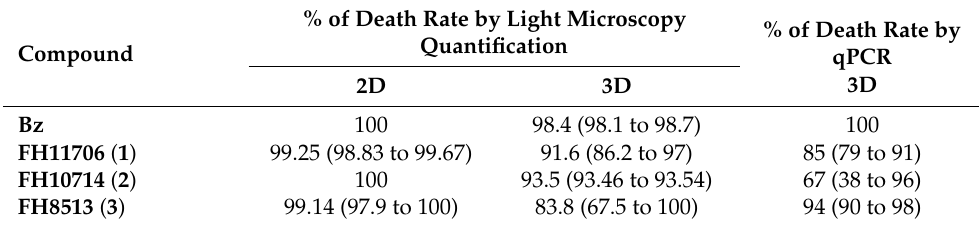
Table 4. Activity of the studied compounds (10 µ M, seven days of incubation) against T. cruzi (Y strain) infection of H9C2 (monolayers and spheroids). The parasite load was determined by light microscopy and qPCR